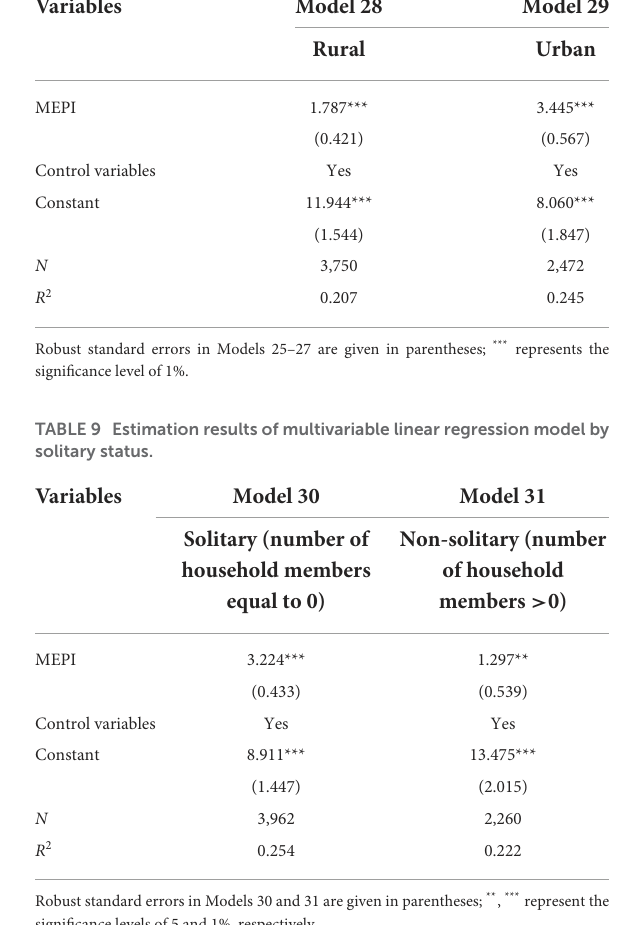
TABLE 7 Estimation results of the multivariable linear regression model by residential area.